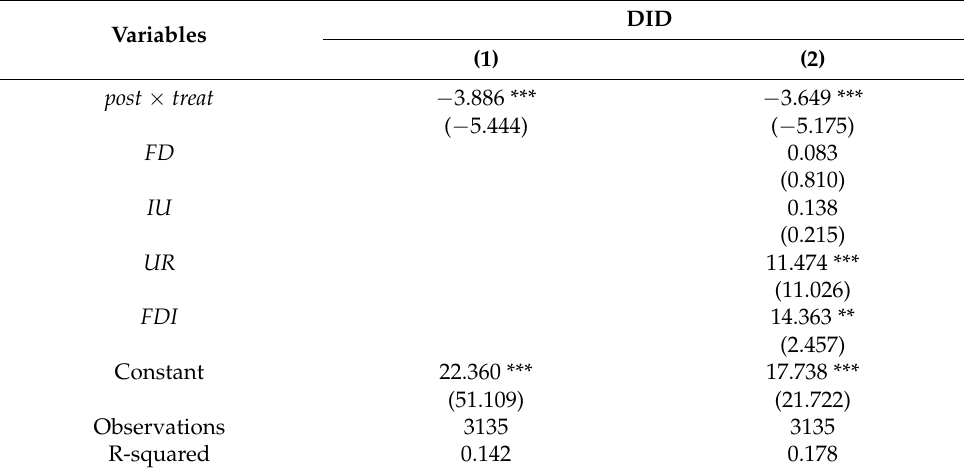
Table 2. Parameter estimation results of the DID model.